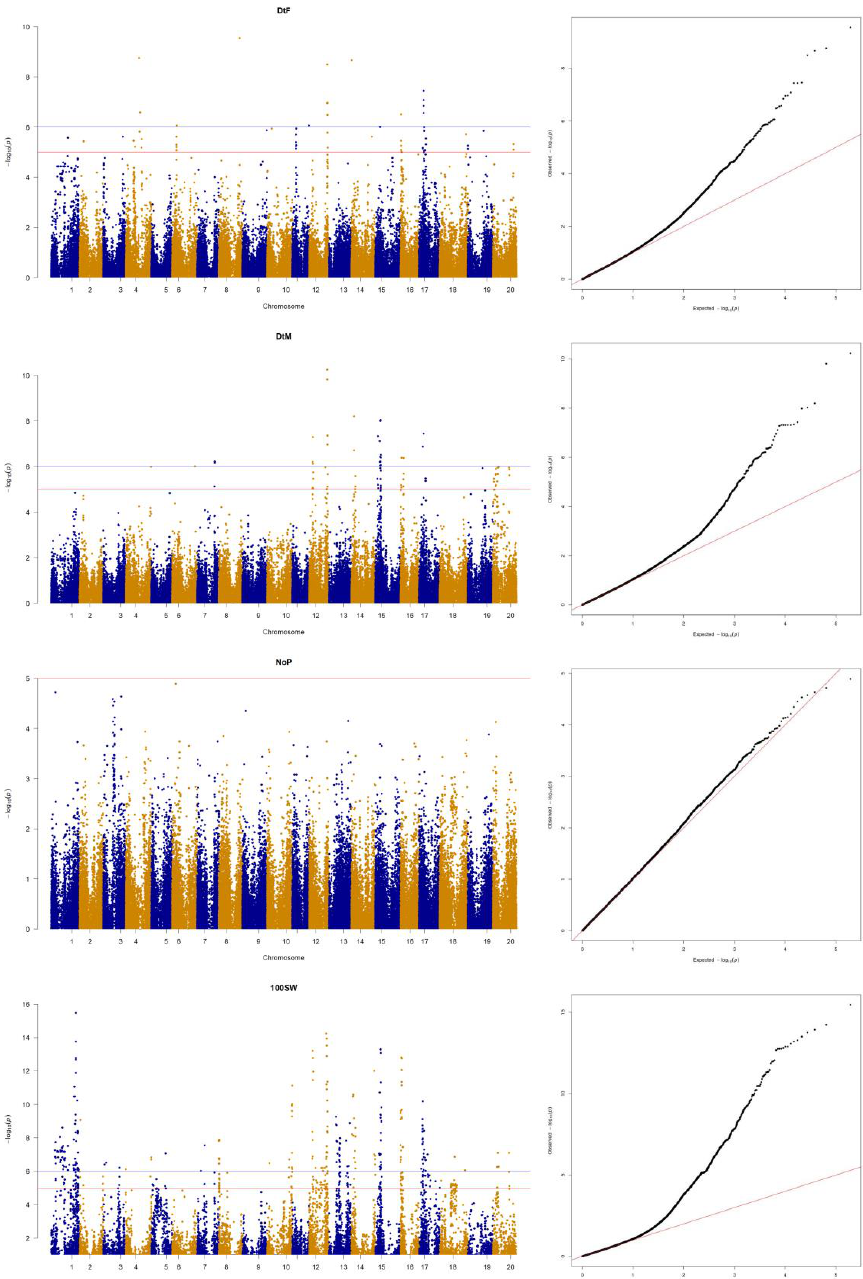
Figure 5. Manhattan plots and quantile–quantile (QQ) plots for four agronomic traits in 203 wild soybean accessions. In the Manhattan plots, the red line indicates the genome-wide threshold -log 10 ( p ) = 4.98 and the blue line represents -log 10 ( p ) = 6.29, calculated using the Bonferroni method. DtF, days to flowering; DtM, days to maturity; NoP, number of pods; 100SW, 100-seed weight.